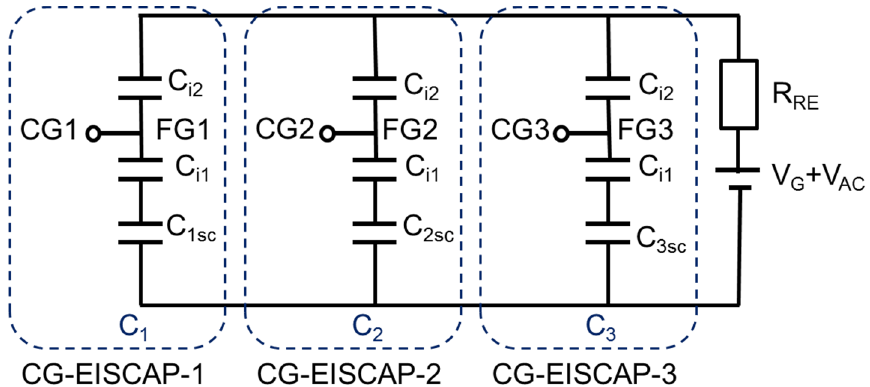
Figure 3. Electrical equivalent circuit of the chip consisting of three CG-EISCAPs. C i 1 and C i 2 : capacitances of insulator-1 and insulator-2, respectively; C 1 sc , C 2 sc and C 3 sc : capacitances of the space-charge region in the semiconductor associated with CG-EISCAP-1, CG-EISCAP-2 and CG-EISCAP-3, respectively; CG1, CG2 and CG3: control gates; V G : gate voltage; V AC : alternating current voltage; R RE : resistance of RE; FG1, FG2 and FG3: floating gates; C 1 , C 2 and C 3 : overall capacitances of CG-EISCAP-1, CG-EISCAP-2 and CG-EISCAP-3,